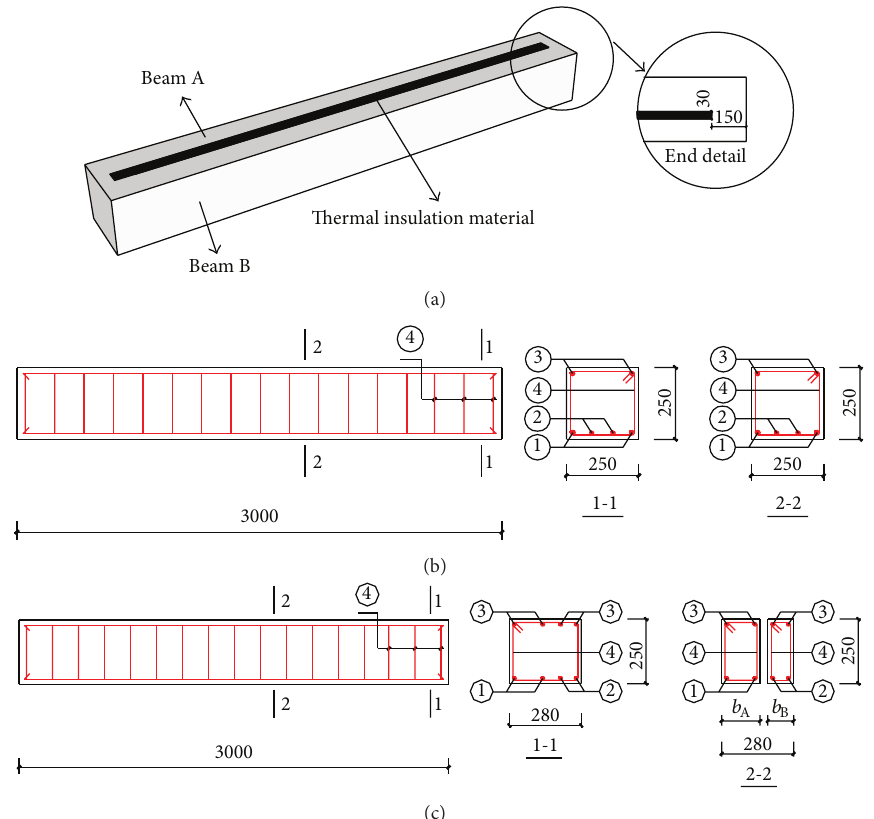
Figure 2: Specimen dimensions and reinforcement: (a) sketch of a slotted beam; (b) solid RC beam; and (c) slotted beam (units: mm).